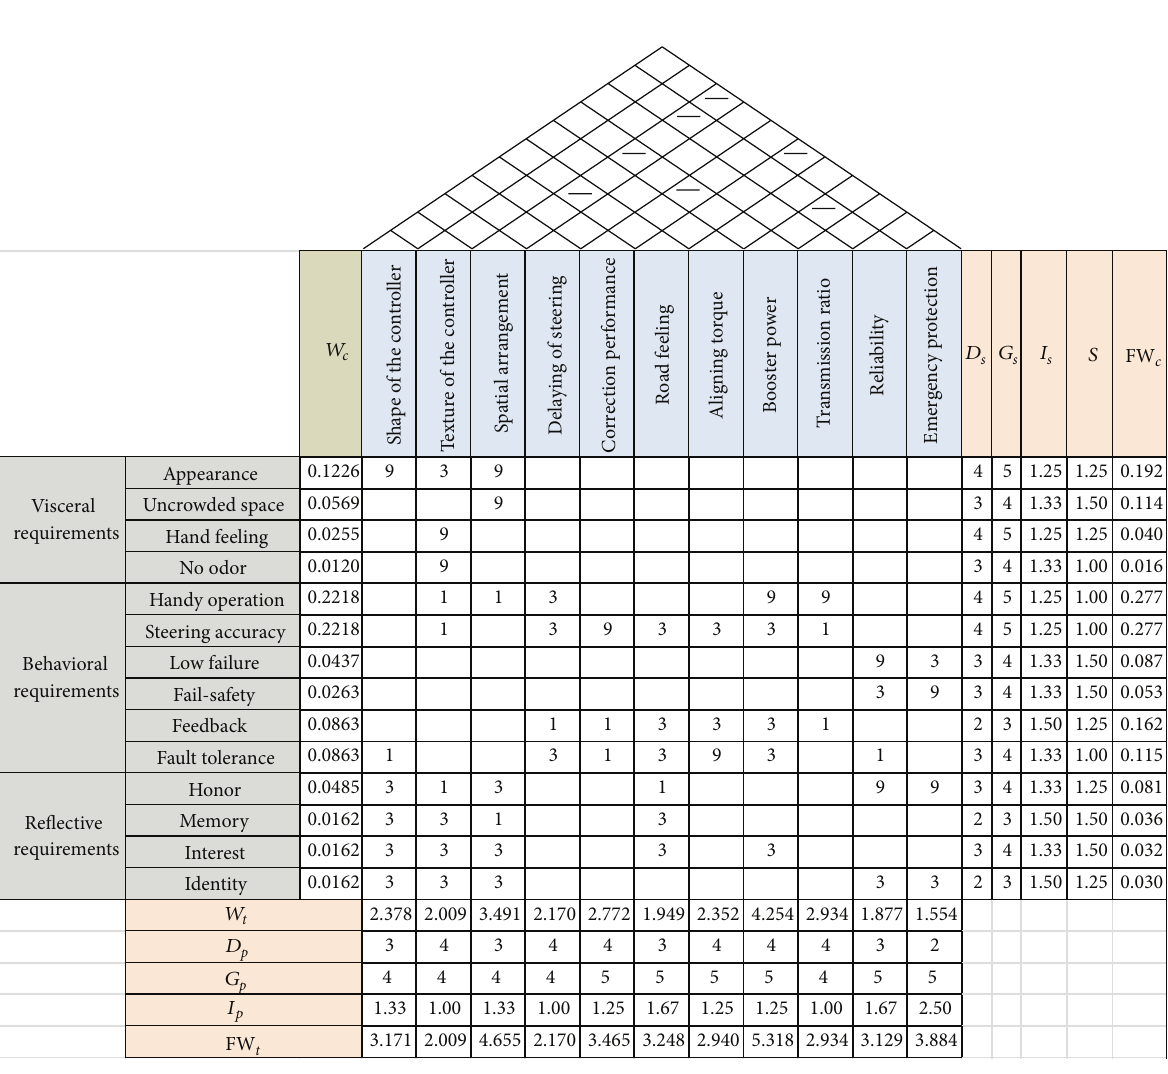
Figure 6: The HoQ for steering